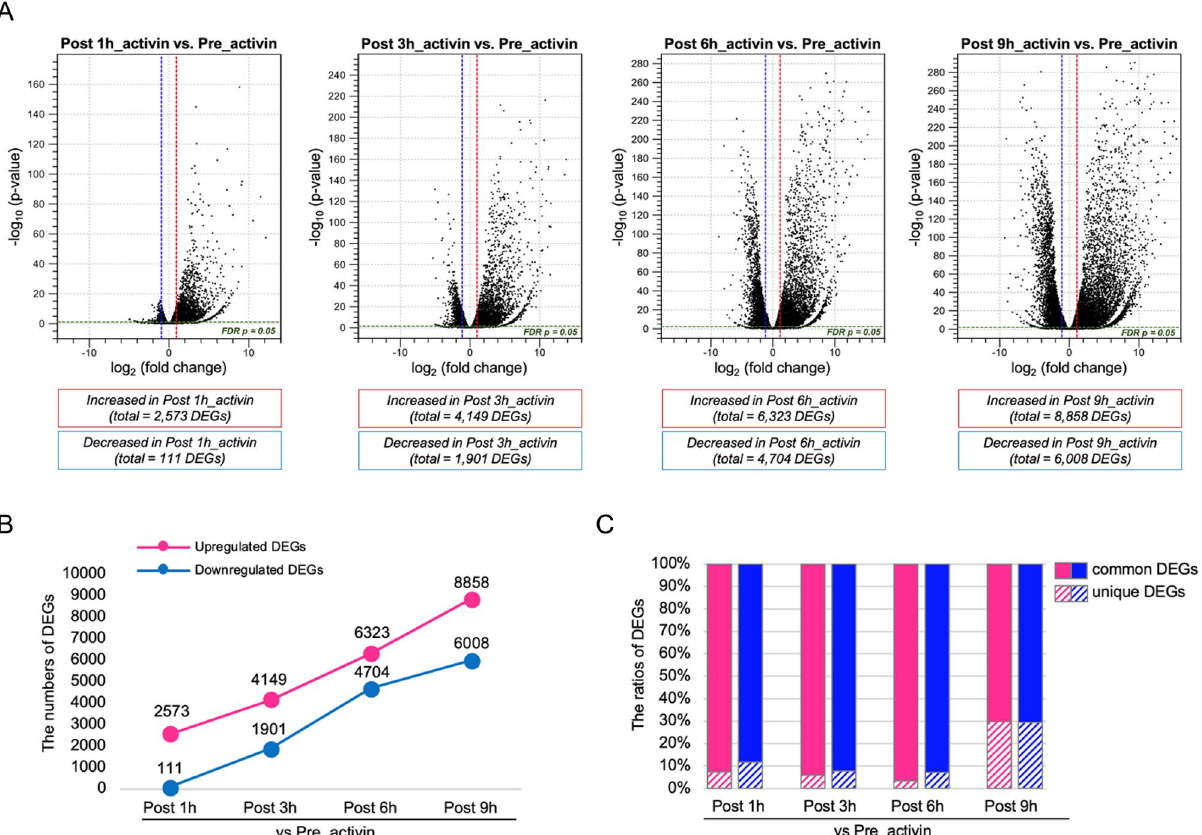
Figure 2. Differentially expressed genes (DEGs) between Pre_activin and each Post_activin sample. DEGs were identified in the comparison of gene expression between Pre_activin and each Post_activin sample based on log2 FC ≥ 2 or ≤ − 2 with FDR at p < 0.05. ( A ) Volcano plots representing DEGs in each comparison. Each dot represents individual DEG. Dotted vertical lines, log2 FC ≥ 2 or ≤ − 2; dotted horizontal line, the significance cut-off (p < 0.05). ( B ) Line graph showing the total number of upregulated and downregulated DEGs in each comparison. ( C ) Bar chart showing the ratio of common DEGs among different Post_activin samples and that of unique DEGs in each Post_activin sample. Common DEGs and unique DEGs are represented by solid or stripe pattern fill, respectively. ( B , C ) Magenta, upregulated DEGs; blue, downregulated